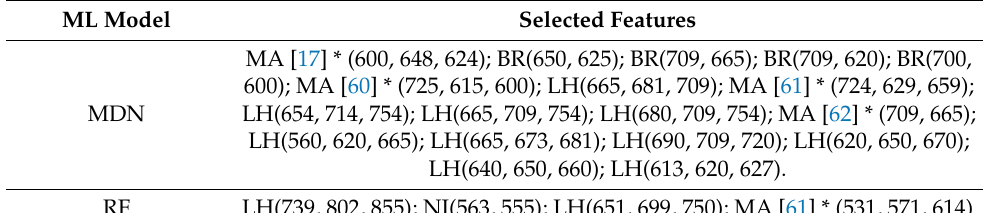
Table 3. Input features used in the ML model to estimate PC concentration